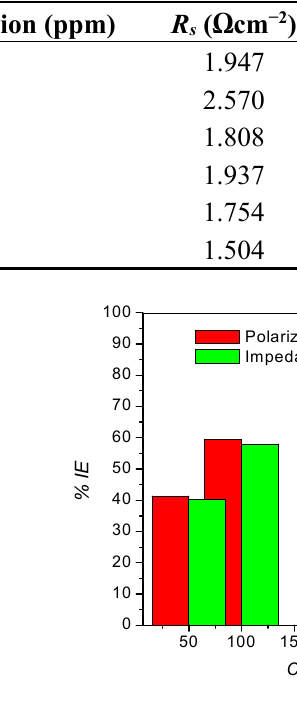
Figure 4. Variation of percentage inhibition efficiency (% IE ) with concentration of SB for both polarization and impedance